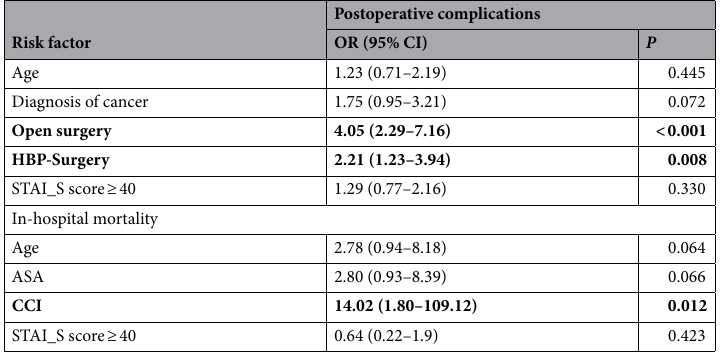
Table 4. Multivariate analysis: predictors of postoperative complications or mortality after adjusting for risk factors (entire cohort, N = 400). Each of the risk factors represents a significant univariate predictor of complications or mortality. OR, odds ratio CI, confidence interval; ASA, the American society of anesthesiologists physical status classification, CCI, the comprehensive complication index. Significant values are in bold.